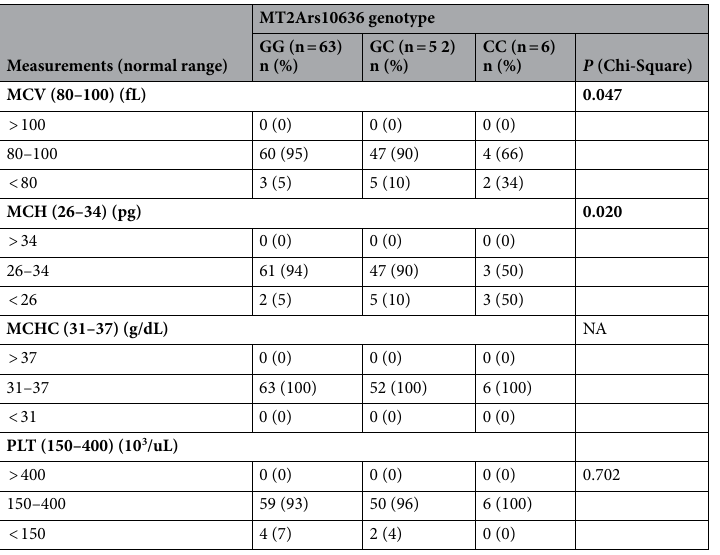
Table 3. Characteristics of blood biochemical indices in the examined residents in Taiwan. Significant values are in [bold].